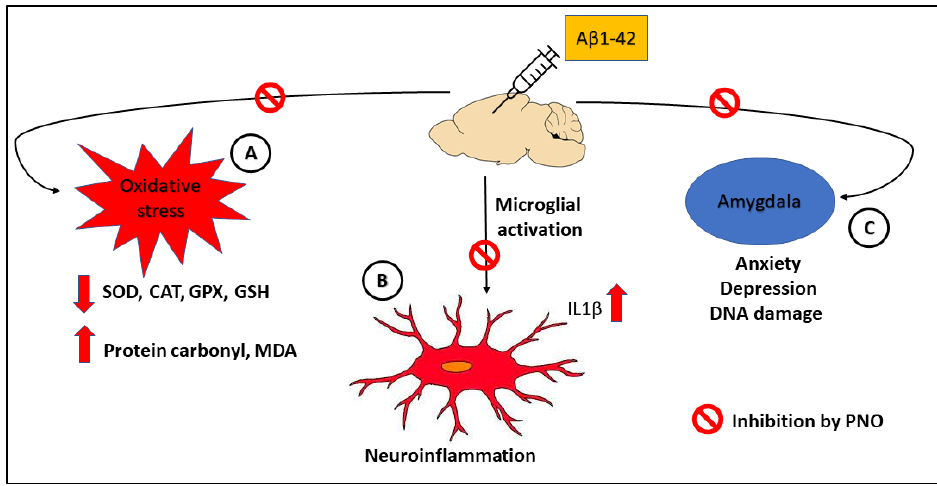
Figure 8. The neuroprotective effects of Pinus halepensis essential oil (PNO) against A β 1-42-induced neuronal dysfunction in the rat amygdala. ( A ) PNO may be able to decrease the oxidative stress level in the rat amygdala by increasing the antioxidant enzymes activity and reducing the protein oxidation (protein carbonyl) and lipid peroxidation (MDA) levels. ( B ) PNO can reduce the level of gliosis (neuroinflammation) in the rat amygdala. ( C ) PNO decrease anxiety–depresive-like behaviors and DNA damage in the rat amygladala.